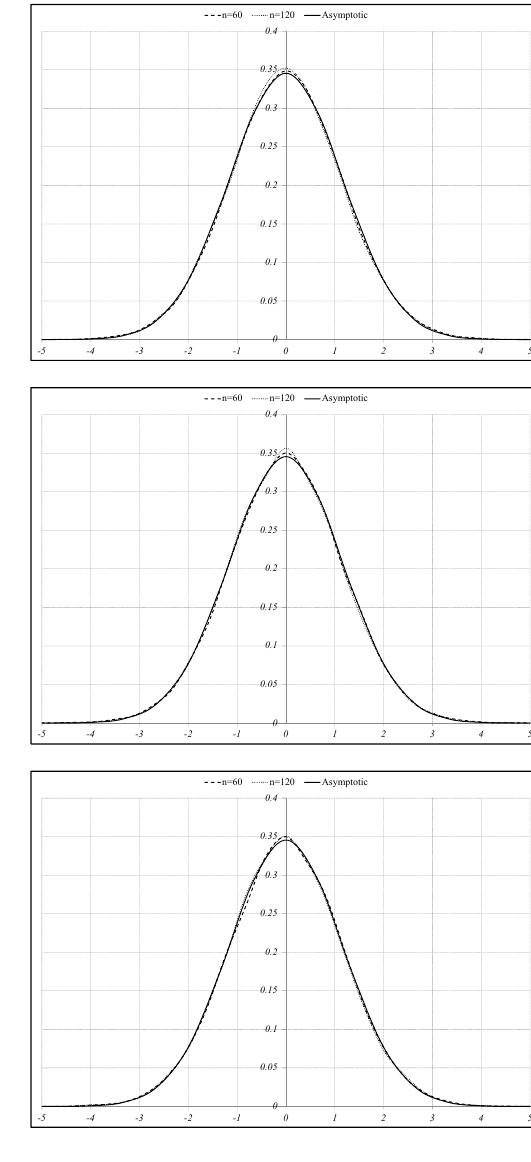
Figure 4. Kernel density estimators for n ∈ { 60, 120 } and the asymptotic density of the standardized estimator for the beta coefficient in the case of the k = 5 ( top left ), k = 10 ( top right ), k = 15 ( middle left ), k = 20 ( middle right ), k = 25 ( bottom left ), abd k = 30 ( bottom right ) dimensional equally-weighted portfolio. The asset returns are drawn from the multivariate t -distribution with 10 degrees of